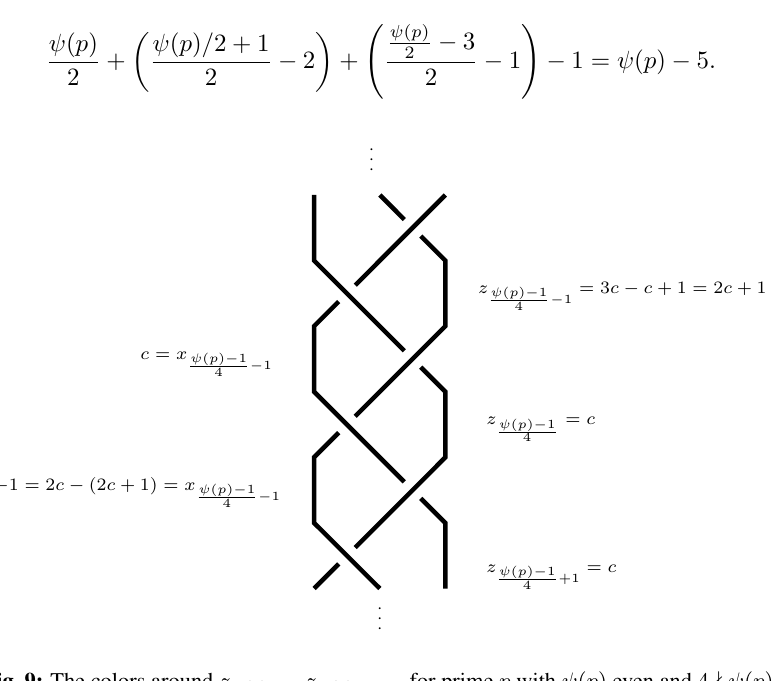
Fig. 9: The colors around z ψ ( p )